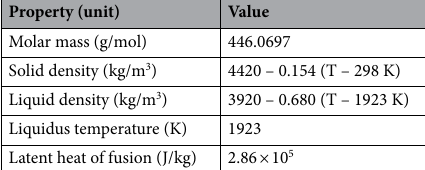
Table 1. Properties of the Ti-6Al-4V alloy 27